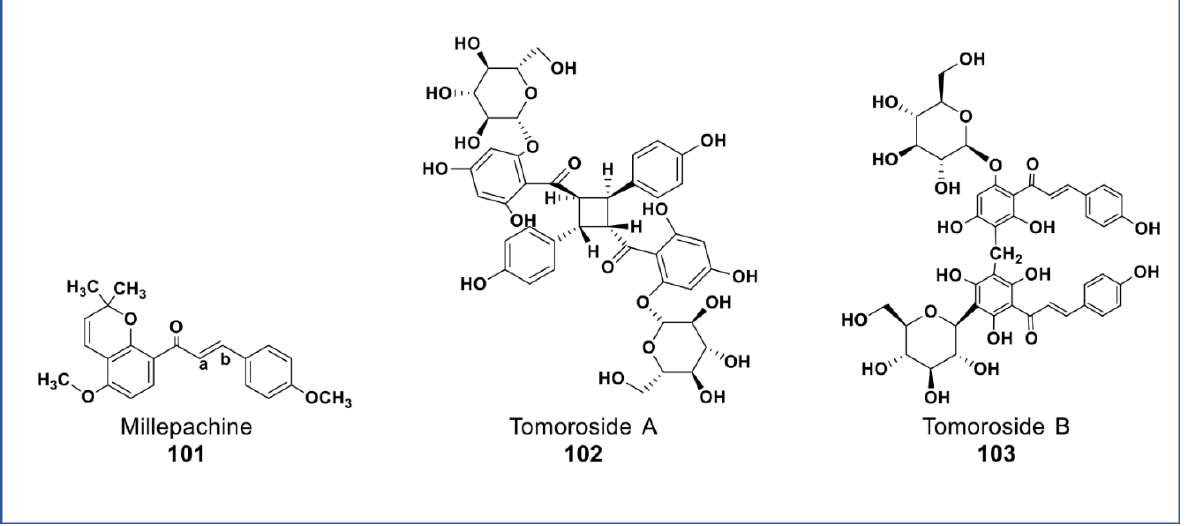
Figure 8. Representative members of new chalcone phytochemicals from various plant sources (compounds 101 to 103 ).